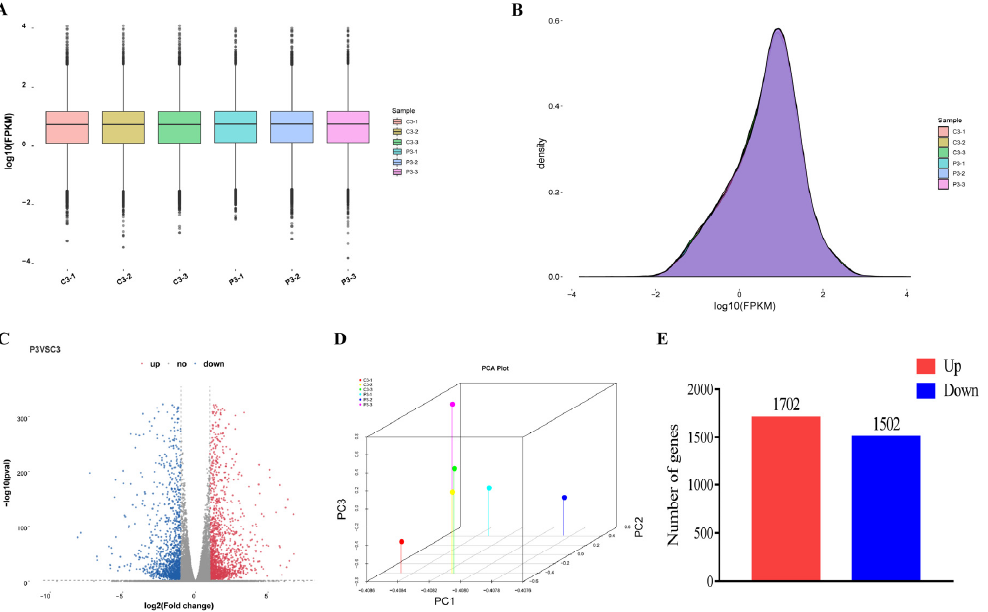
Figure 2. Expression levels of each sample. The boxplot showed the gene expression ( A ). The height of the curves represents density ( B ). The volcano indicates the differentially expressed genes (DEGs). Each dot in the figure signifies a particular DEG. The red dot shows upregulated DEGs. The blue dot indicates downregulated DEGs, and the dark grey dot is a nonsignificant differential gene ( C ). Principal Component Analysis (PCA) denotes gene expression levels ( D ). The number of upregulated and downregulated genes ( E ).